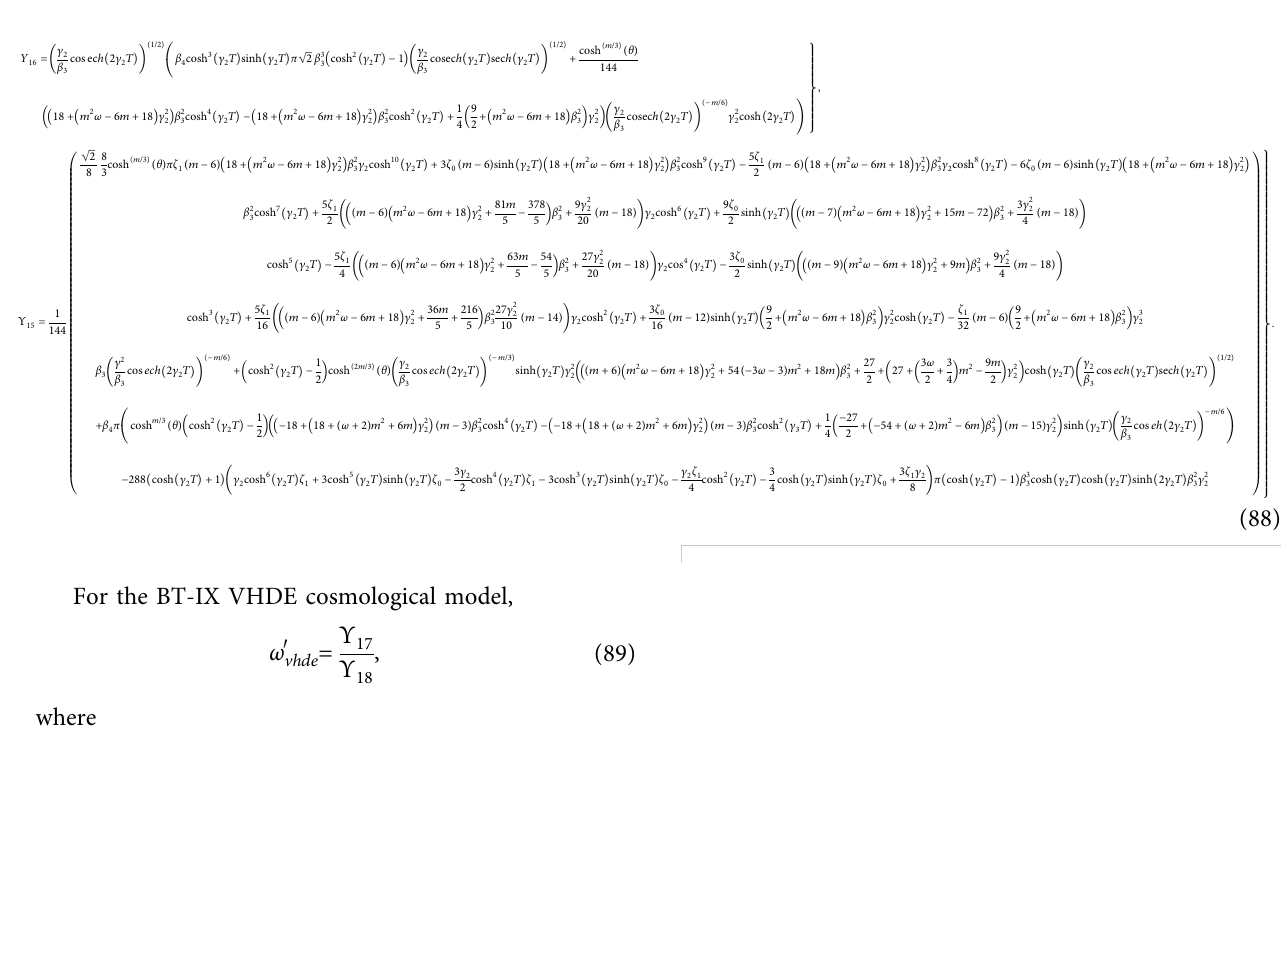
Figure 18: EoS parameter versus redshift ( z ) for